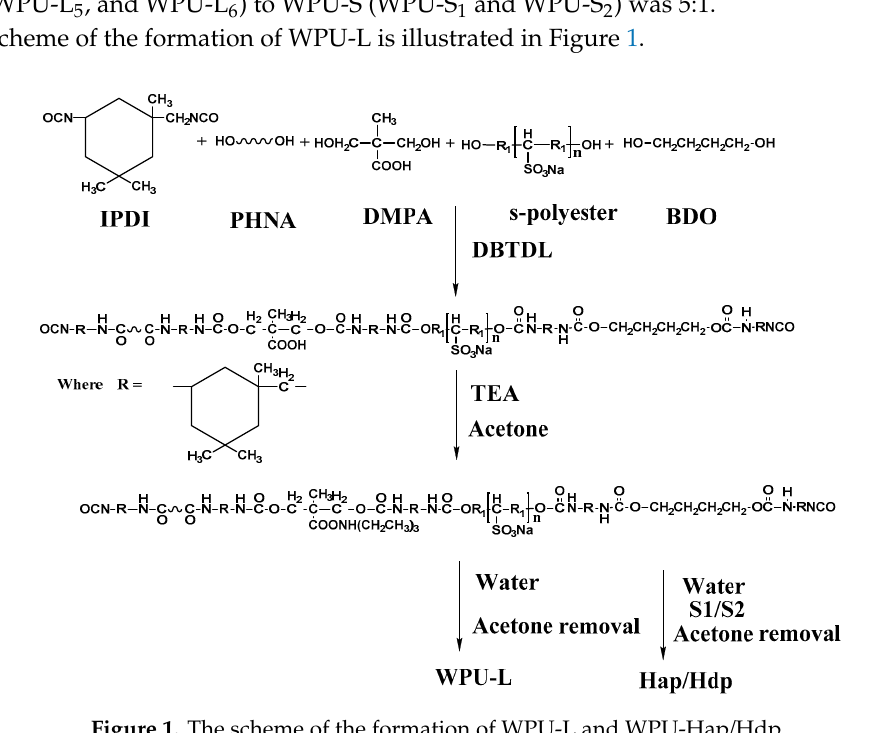
Table 2. The formulation of large-particle waterborne polyurethane (WPU-L).